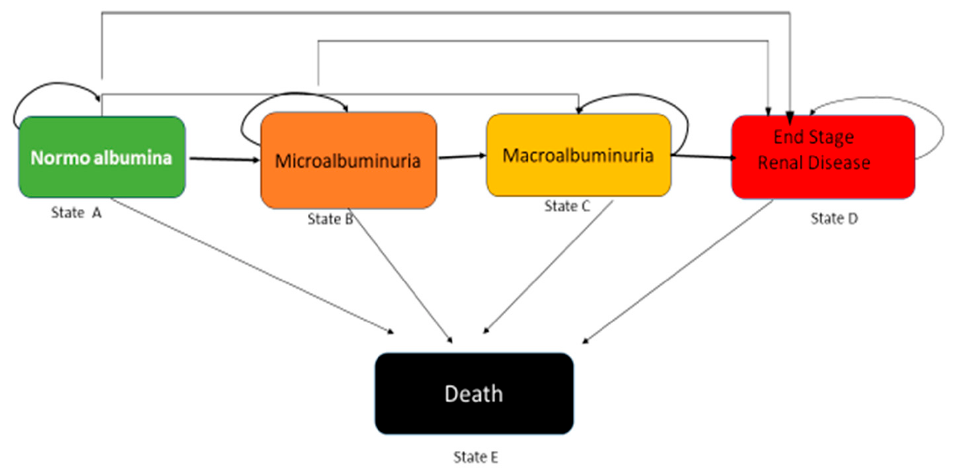
Figure 1. The direction of the arrows symbolizes the proportion of patients progressing toward the different stages. The returning arrows symbolize the proportion of patients who remained in each stage.